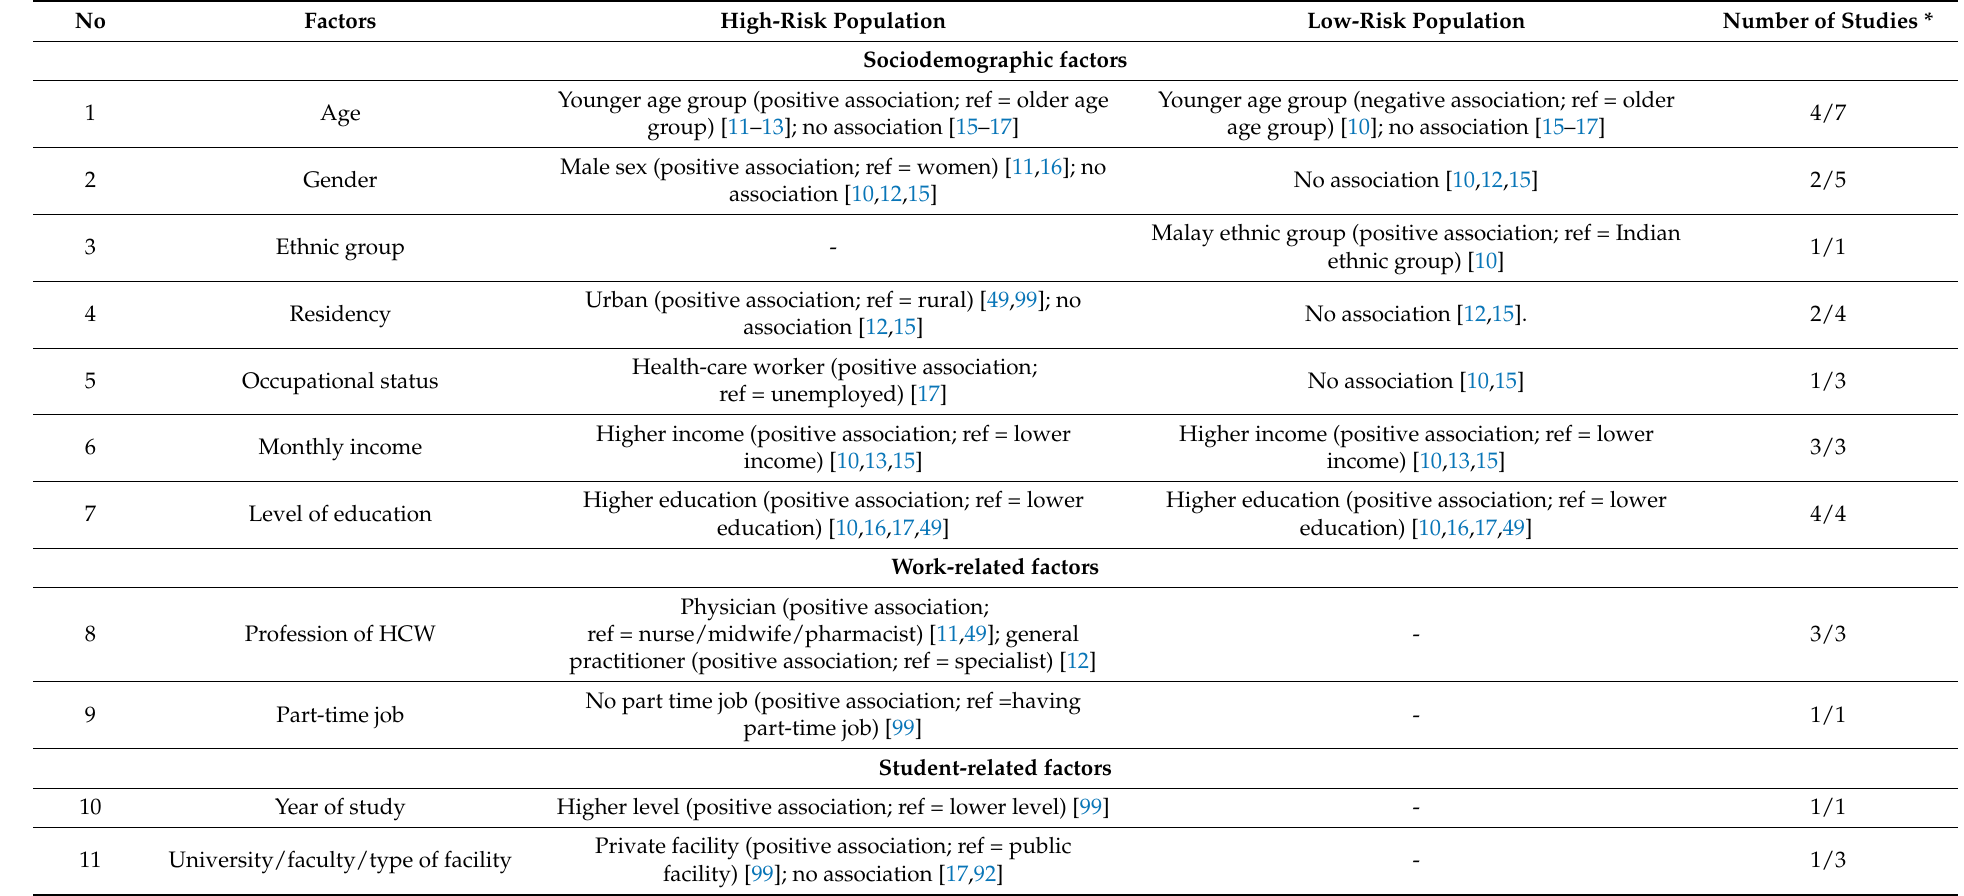
Table 3. The determinants of hepatitis B